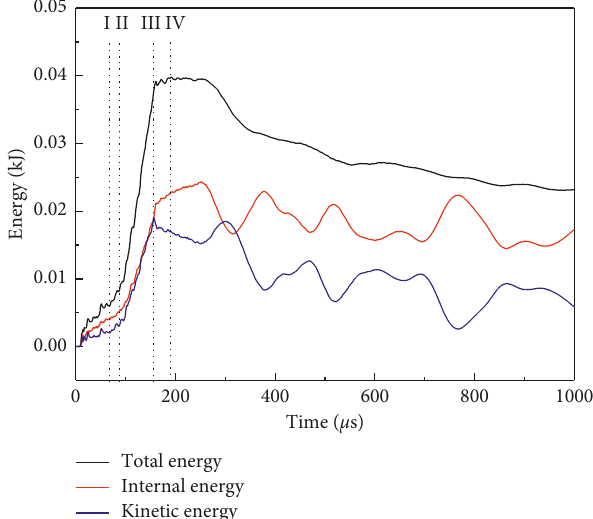
Figure 27: Peak energy curves of the response